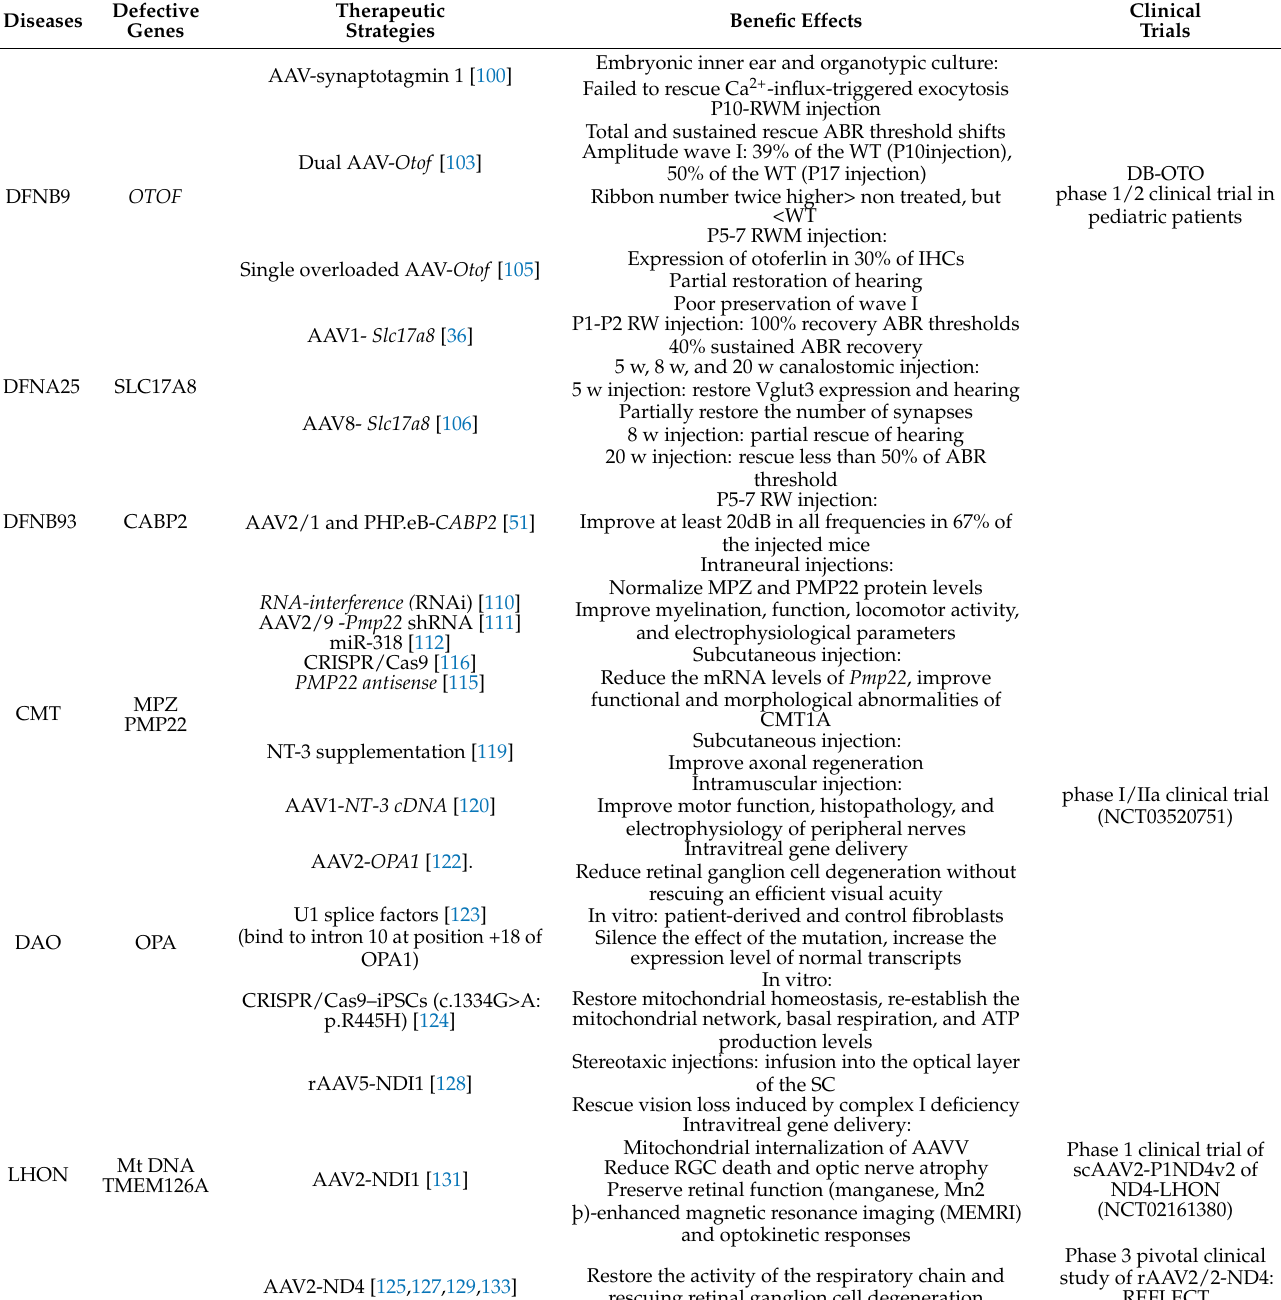
Table 1. Gene therapies for genetic synaptopathies and neuropathies that have been discussed in this review.